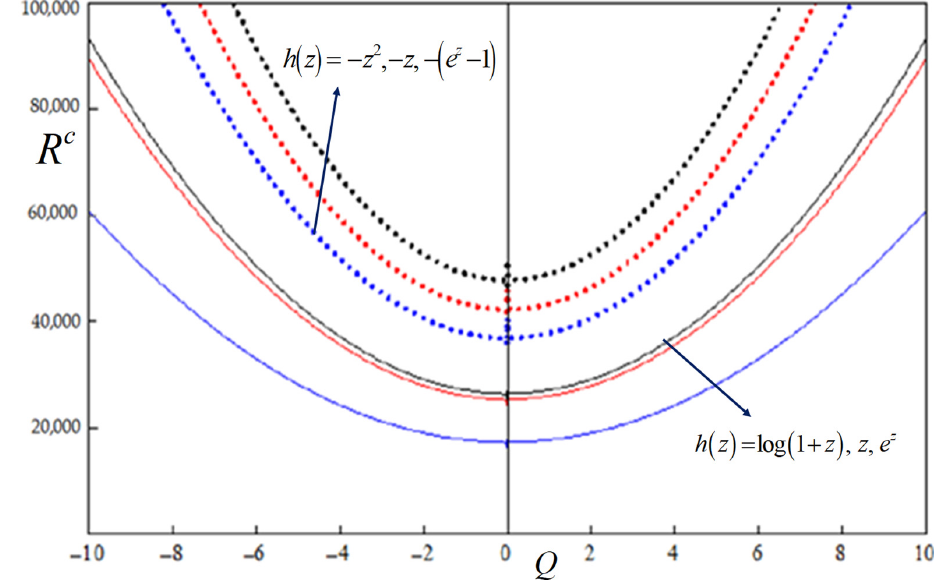
Figure 5. Plot of R c versus Q for different scenarios of gravity with Le = 0.5, Rs = 10, Da = 100, ξ = 0.5, η = 0.5 and δ = 0.5.